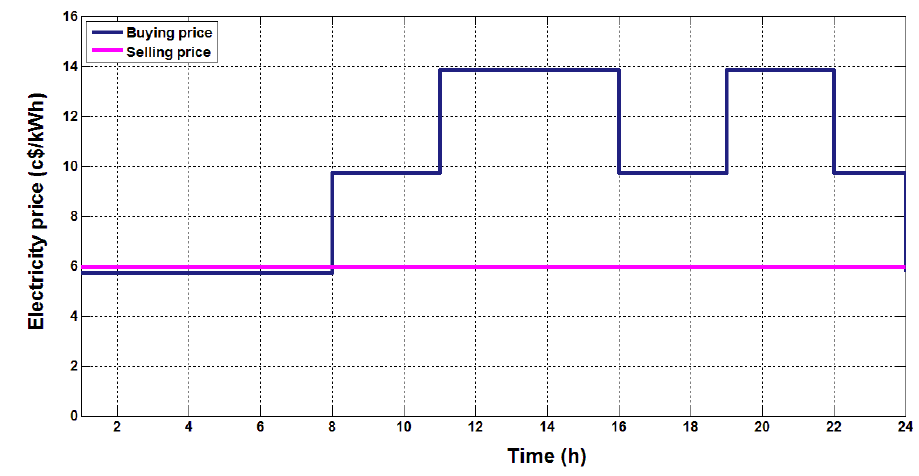
Figure 6. Electricity buying and selling prices.